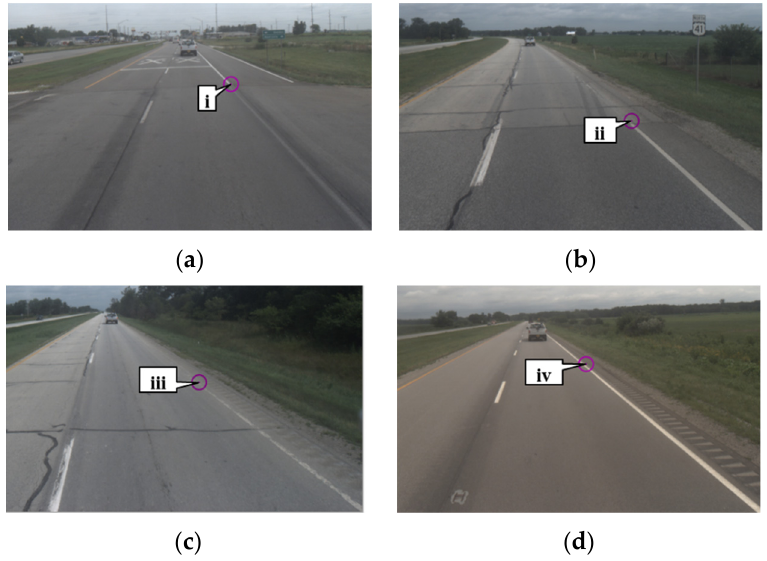
Figure 6. US-41 northbound intensity validation points: ( a ) mile marker: 33.84; ( b ) mile marker: 45.64; ( c ) mile marker: 48.22; ( d ) mile marker: 60.76.